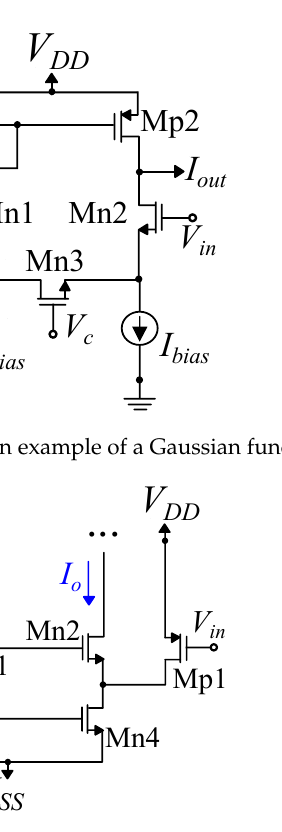
Figure 36. A different example of a Gaussian function circuit based on an exponentiator circuit. Table 6. Gaussian Function Circuits with other implementations. * Additional current sources, resistors or capacitors. ** Power consumption for the entire